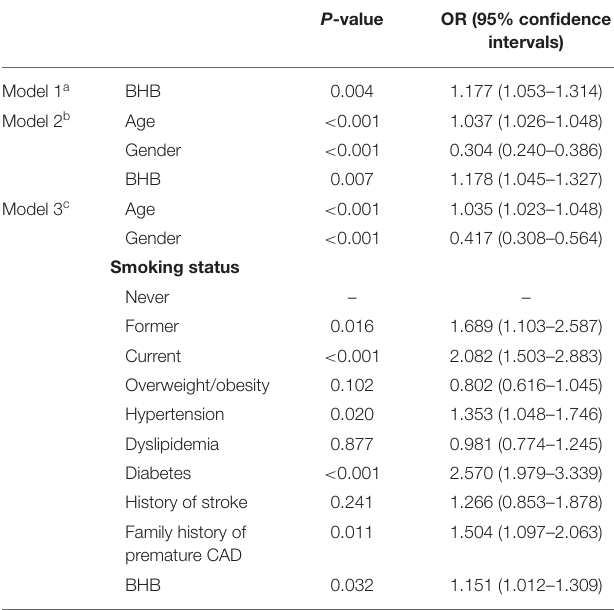
TABLE 3 | Odds ratios (95% CI s) and p for the severity of coronary artery lesion. P